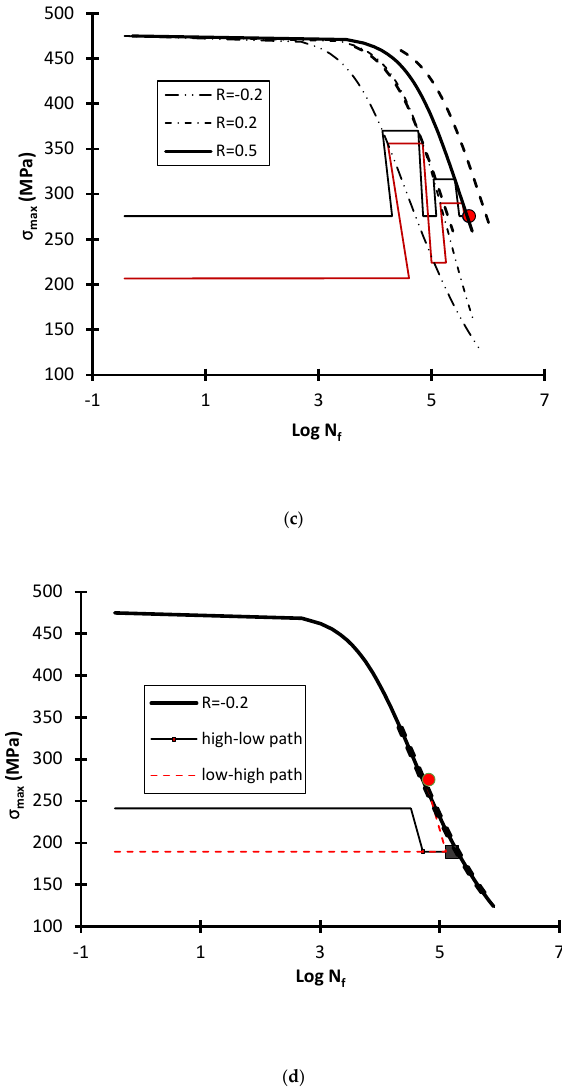
Figure 3. Fatigue loading schemes and failure points: ( a ) high-low loading for R = − 0.2 and R = 0.2; ( b ) low-high loading for R = − 0.2 and R = 0.2; ( c ) loading for R = − 0.2, 0.2 and 0.5; and ( d ) high-low and low-high loadings for a single stress ratio R = − 0.2.